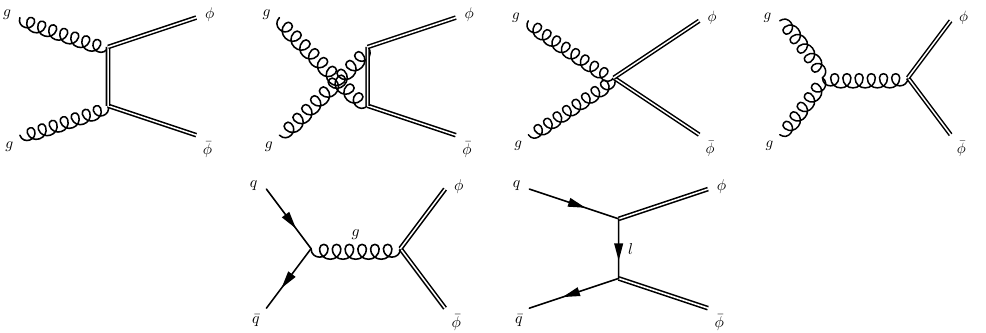
Figure 3 . Diagrams for leptoquark pair production: gluon-initiated ( upper row ), quark-initiated ( lower-left ), and diagram proportional to the square of the leptoquark-lepton-quark coupling, (cid:21) 2 ( lower-right